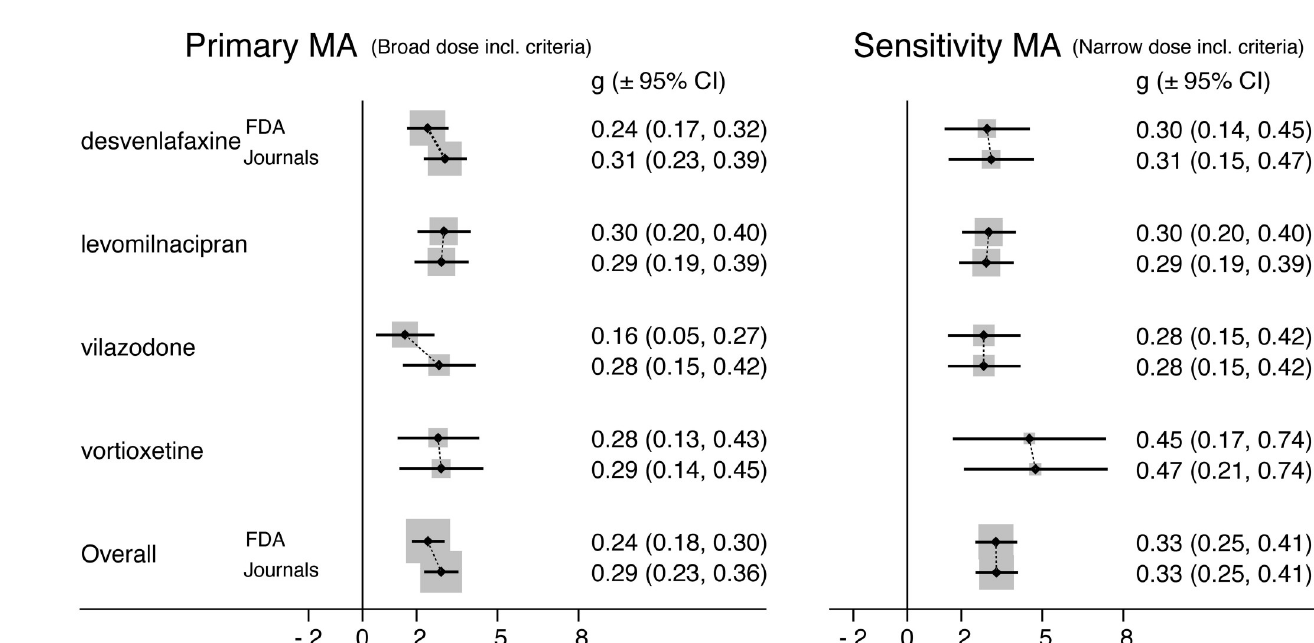
PLOS Medicine| https://doi.org/10.1371/journal.pmed.1003886 January 19,